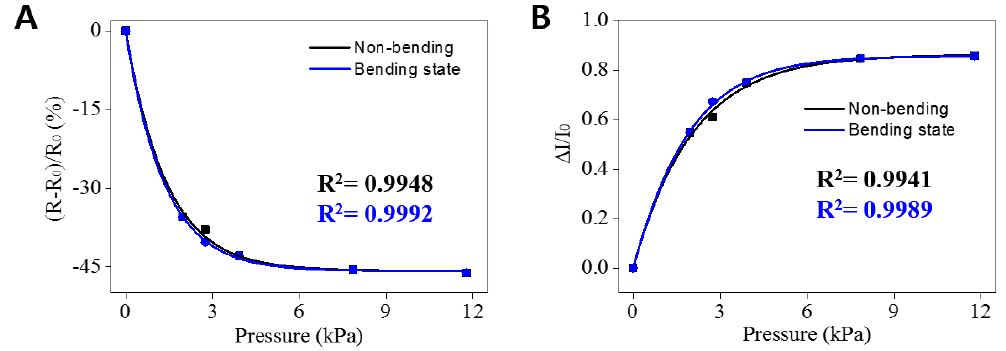
Figure 5. Responses of a sandwich-type pressure-responsive sensor device of elastic AgNW-PEG composite hydrogel patterns on flexible PET (1 mm line pattern width). ( A ) Relative resistance change (RCR), and ( B ) relative current change (RCC) of the sensor with bending or non-bending state under various pressures (1.96, 2.75, 3.92, 7.85, and 11.77 kPa, 1.5 cm bending radius).